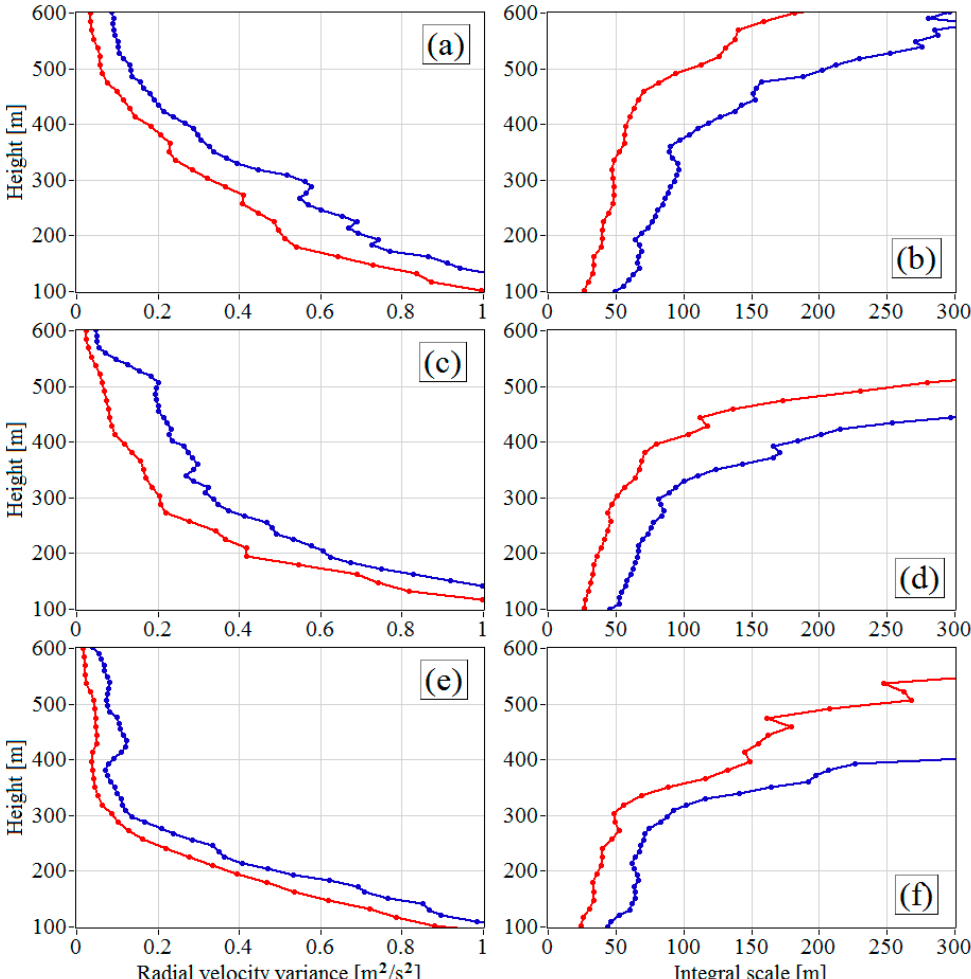
Figure 6. Vertical profiles of the ( a , c , e ) radial velocity variance and ( b , d , f ) integral scale of turbulence retrieved from measurements by the lidar at the elevation angles of 35.3° (blue curves) and 60° (red curves) at ( a , b ) 21:00 LT on 23 July, and ( c , d ) 00:00 and ( e , f ) 03:00 LT on 24 July 2018.